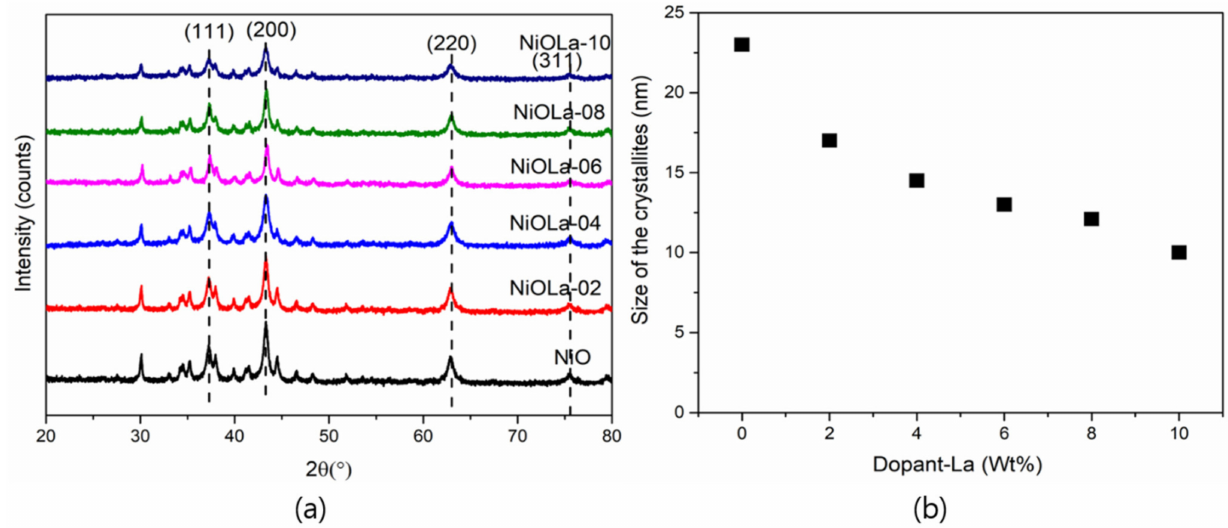
Figure 1. ( a ) X-ray diffraction analysis of NiO and La 3+ ion-doped NiO nanoparticles. ( b ) Calculated average crystallite size with the